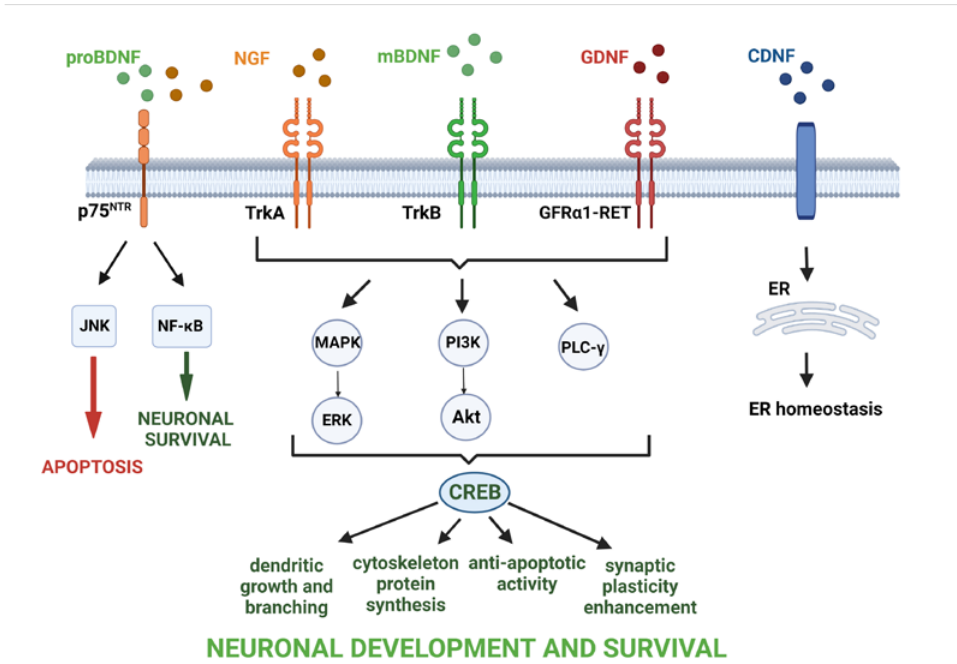
Figure 3. Signaling cascades activated by neurotrophic factors (NTFs). The precursor of brain-derived neurotrophic factor (proBDNF) or nerve growth factor (NGF) binding the p75 NTR leads to activation of c-Jun N-terminal kinase (JNK) or nuclear factor kappa-light-chain-enhancer of activated B cells (NF- κ B) signaling pathways, which promote processes such as apoptosis and neuronal survival. The mature brain-derived neurotrophic factor/tropomyosin receptor kinase B (mBDNF/TrkB), NGF/tropomyosin receptor kinase A (TrkA), and glial cell-derived neurotrophic factor/GDNF family receptor α 1/ receptor tyrosine kinase rearranged during transfection (GDNF/GFR α 1-RET) complexes trigger activation of mitogen-activated protein kinase (MAPK), phosphoinositide 3-kinase (PI3K)/protein kinase B (Akt), and phospholipase C- γ (PLC- γ ) pathways that, in turn, activate the cAMP response element-binding protein (CREB) and transcription of genes responsible for development and survival of neurons. Cerebral dopamine neurotrophic factor (CDNF) receptors and CDNF-activated signaling pathways are still poorly understood, but the mechanism of CDNF action is associated mainly with the regulation of endoplasmic reticulum (ER) function. The figure was created with